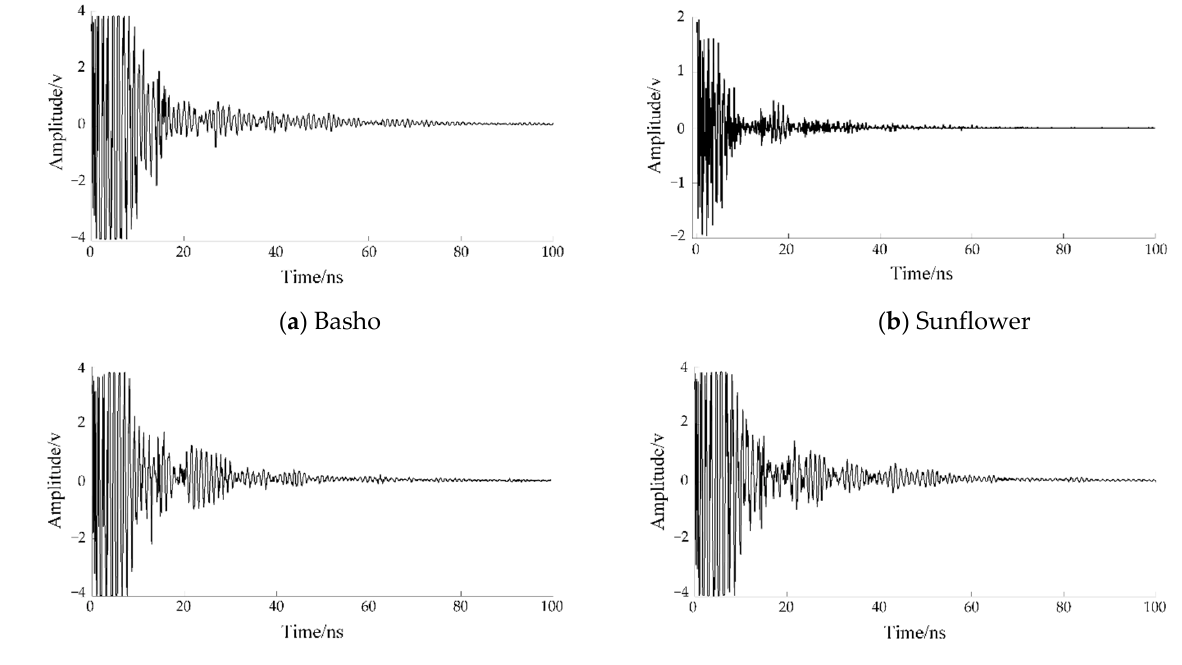
Figure 3. Ultrasonic wave of plant stems in time